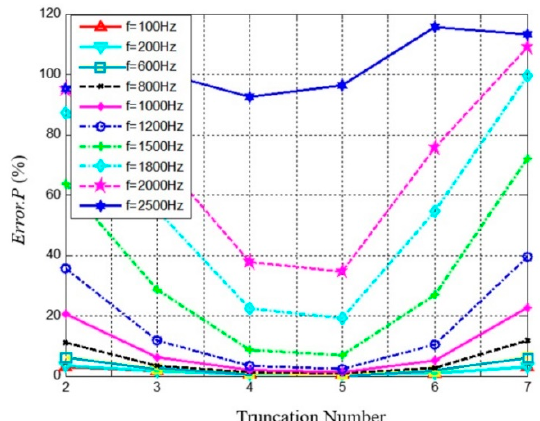
Figure 2. The reconstruction errors of different truncation numbers in different sound frequency ( r = 0.1 m).